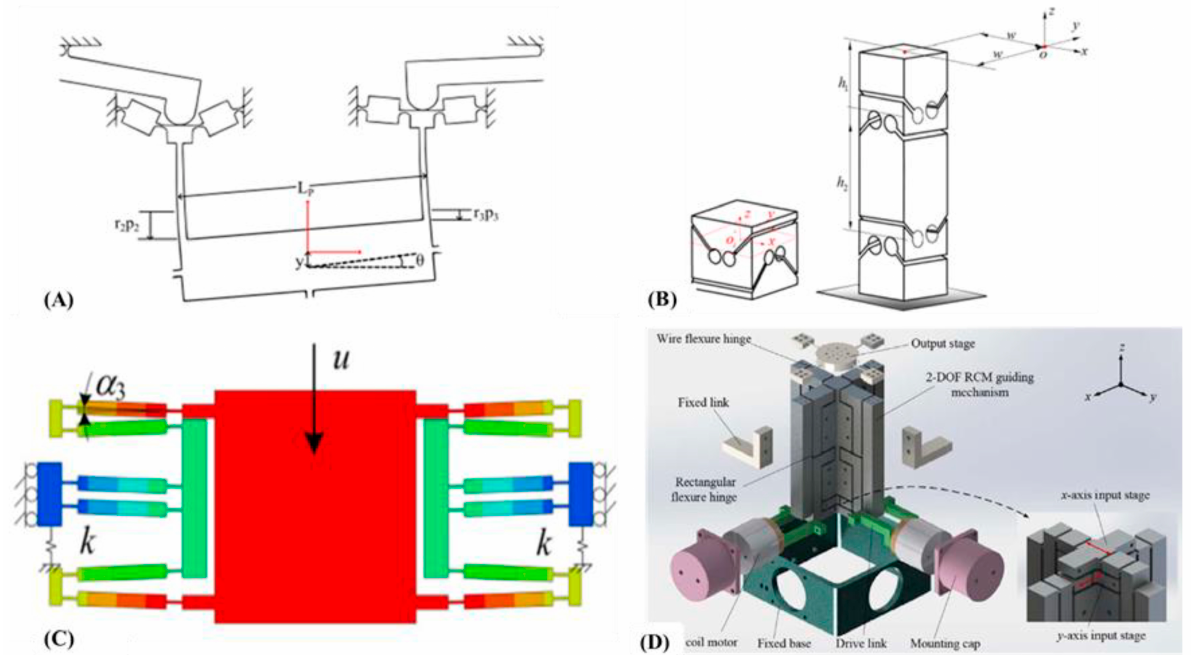
Figure 7. ( A ) Coupled motion example where two topside hinges are actuated in an upwards direction and the center stage exhibits coupled rotation [55]; ( B ) Motion decoupling method with a hook joint flexure hinge and its linear-stacked leg version [54]; ( C ) A parallelogram hinge (blue) parallel connected with prismatic joint (green and orange) [56]; ( D ) A wire flexure hinge (at top)